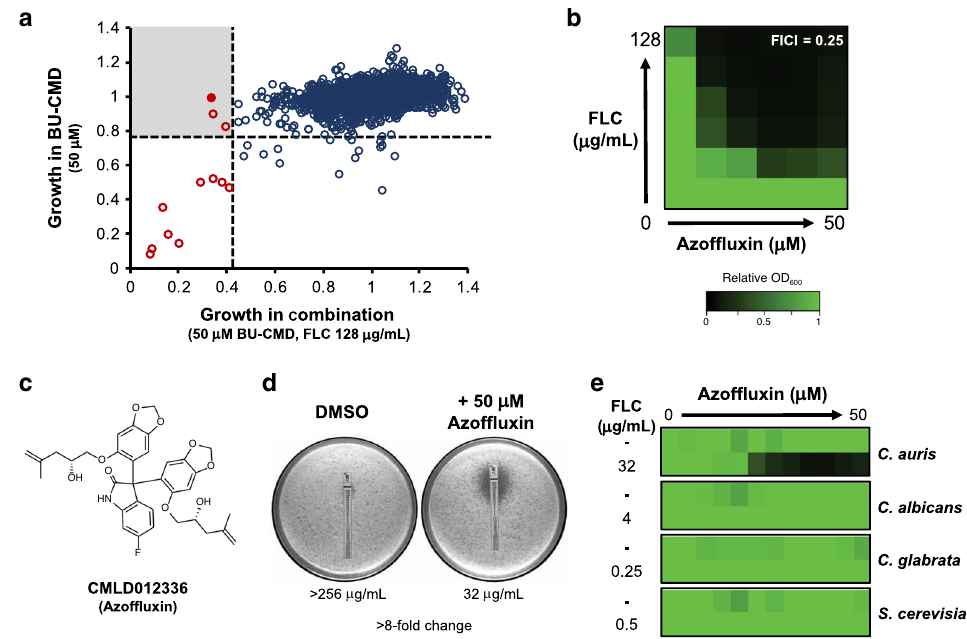
Fig. 1 Screen of the BU-CMD library identi fi es azof fl uxin as a fl uconazole (FLC) potentiator against C. auris . a BU-CMD library was screened at 50 μ M in the presence or absence of 128 μ g/mL of FLC in RPMI medium at 30 °C for 48 h. Growth of C. auris strain VPCI 673/P/12, as determined by optical density at 600nm (OD 600 ), is plotted in the presence of each CMD compound alone and in combination with FLC. Dotted lines represent 7-median absolute deviations from the median for each condition. Red circles indicate compounds that showed signi fi cant bioactivity. The shaded quadrant indicates compounds that show enhanced activity in the presence of fl uconazole, with azof fl uxin shown as a fi lled red circle. b Checkerboard assays with azof fl uxin (CMLD012336) and FLC were performed in RPMI at 30 °C by titering 2-fold dilution series of azof fl uxin and FLC. Growth in each well is presented in heat- map format based on the OD 600 of wells at 48 h relative to the no-drug control (see color bar). The fractional inhibitory concentration index (FICI) was calculated to assess interaction effect, with a value <0.5 indicating synergy. c Structure of CMLD012336 (azof fl uxin). d FLC Etest strips in the presence and absence of 50 μ M azof fl uxin. C. auris cells (1 × 10 6 ) C. auris cells were plated on YPD agar, the E-test strip was added, and plates were incubated at 30 °C for 24 h prior to imaging. e Dose-response assay based on 2-fold serial dilution of azof fl uxin starting from 50 μ M in the absence and presence of indicated concentration of FLC for C. auris Ci6684 (Erg11 Y132F ) , C. albicans (SN95) , C. glabrata (BG2), or S. cerevisiae (BY4741), respectively. The highest FLC concentrations that did not affect growth alone for each species was used. Dose-response assays were incubated for 48 h at 30 °C in RPMI. Growth in each well was quanti fi ed by the OD 600 of treated wells relative to the respective no-drug control (see color bar in b ). Source data are provided as a Source Data fi (Tac1b WT ). The fractional inhibitory concentration index (FICI) calculated for the combination was 0.25, with values <0.5 indi- cating a synergistic interaction (Fig. 1b) 30 . As a complementary approach, we used fl uconazole E-test strips to determine whether synergy could also be observed on solid medium. In the absence of azof fl uxin, C. auris grew up to the highest concentration of fl uconazole present on the E-test strip. Strikingly, the presence of azof fl uxin (50 μ M) reduced the fl uconazole minimum inhibitory